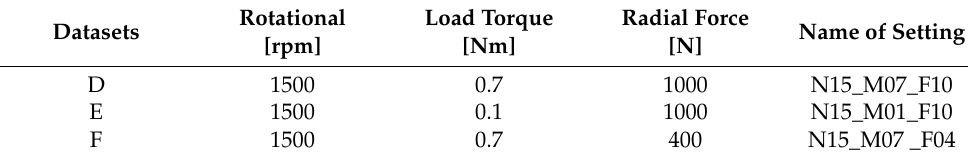
Table 12. Working conditions of test bearing on Paderborn dataset.